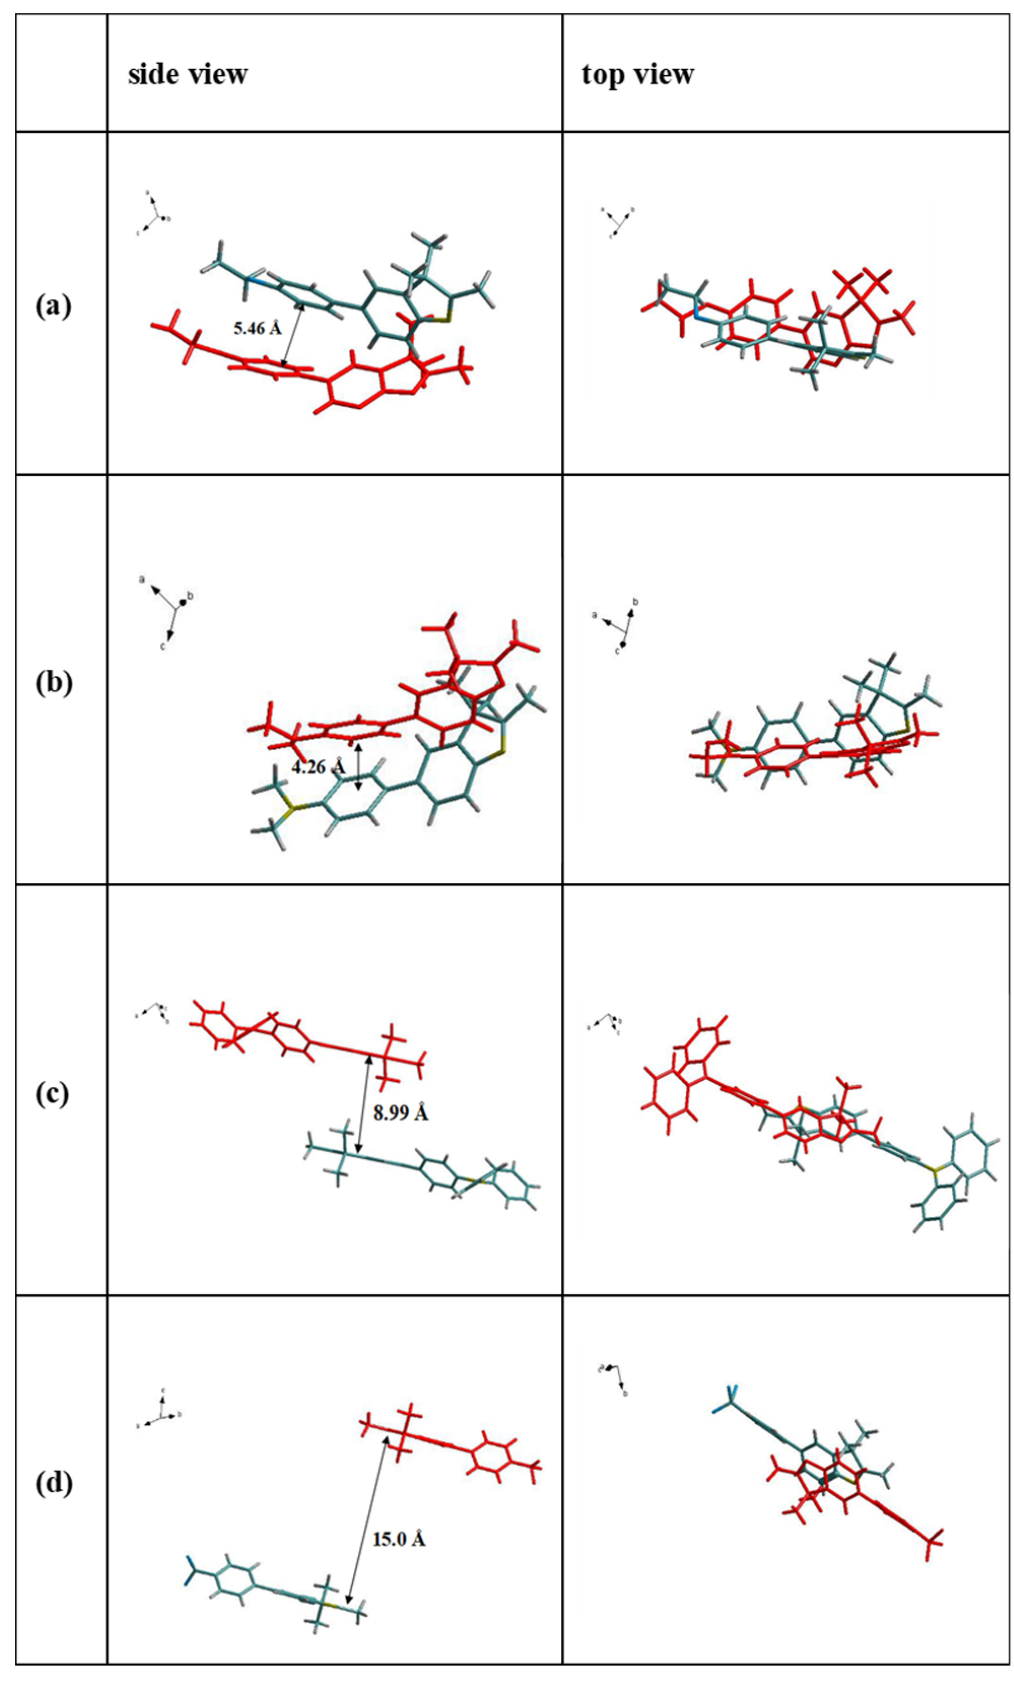
Figure 7. Packing structure of ( a ) PI-C , ( b ) NI-C , ( c ) TI-C and ( d ) FI-C.